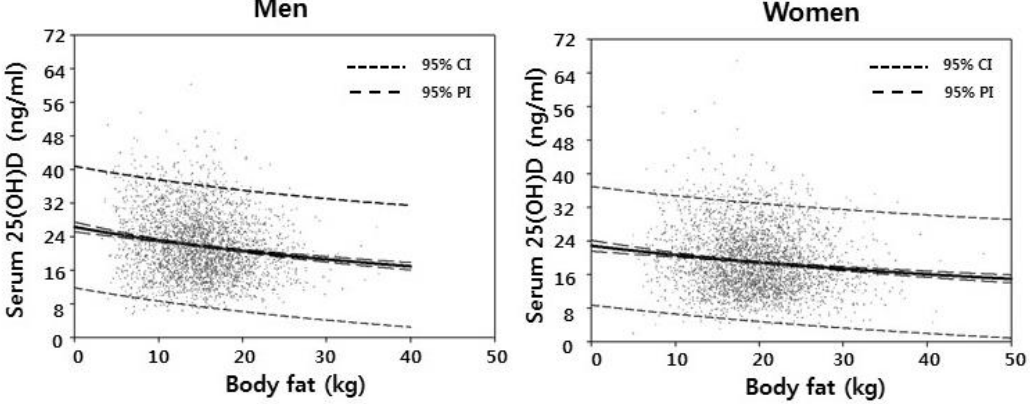
Figure 2. Regression lines of serum 25-hydroxyvitamin D concentration with total body fat in men and women. 95% CI means 95% Confidence Interval, 95% PI means 95% Prediction Interval, and 25(OH)D means 25-hyroxyvitamin D.